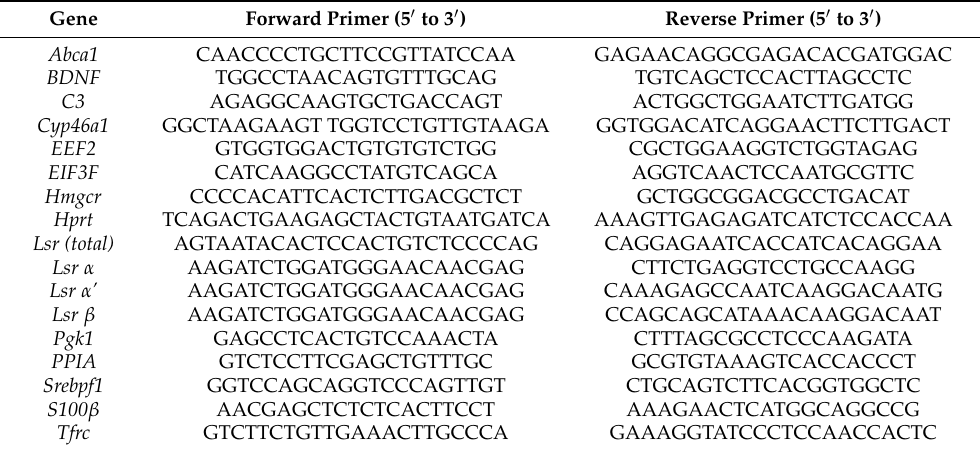
Table 1. Sequences of RT-qPCR primers used in the study. Forward and reverse primers of the reference genes used: EEF2, EIF3F, Hprt, Pgk1 , PPIA, and Tfrc . Target isoforms of Lsr : total (T), α , α ’, and β . Cholesterol metabolism genes: abca1 , cyp46a1 , hmgcr, and srebp1 . Inflammatory and neurotrophic genes: BNDF, C3, and S100 β